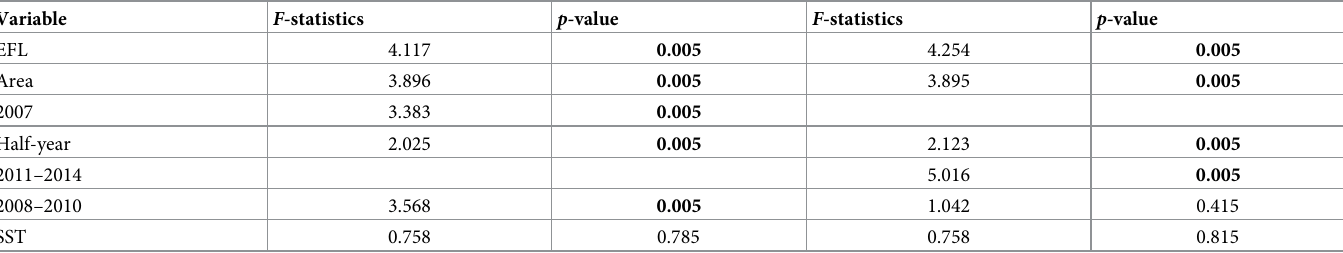
Table 4. Results of redundancy analysis (RDA) of variation in diet composition of swordfish (based on prey numbers). Values of F and associated probability ( p - value) are tabulated for two sets of model runs. The variable ‘year’ (fishing season) was divided into three categories (2007, 2008–2010 and 2011–2014) and converted into three (0,1) dummy variables. Since the category may be identified once the values of two of the dummy variables have been defined, all three dummy variables cannot be included in the same run of the model. Left: model runs excluding 2011–2014. Right: model runs excluding 2007. (EFL = eye to fork length, Area = within the SCB and beyond the SCB, Half-year = August 15 th through November 7 th and November 8 th through January 31 st ).